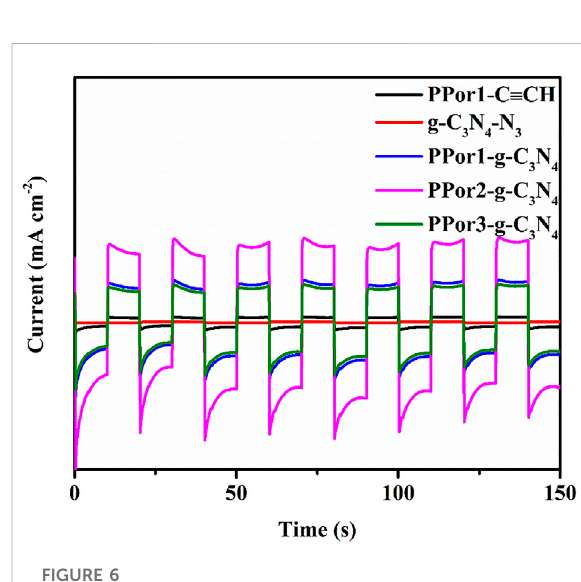
FIGURE 6 Photocurrent responses of PPor1-C ≡ CH, g-C 3 N 4 -N 3 and PPorx-g-C 3 N 4 (x = 1, 2 and 3) under chopped